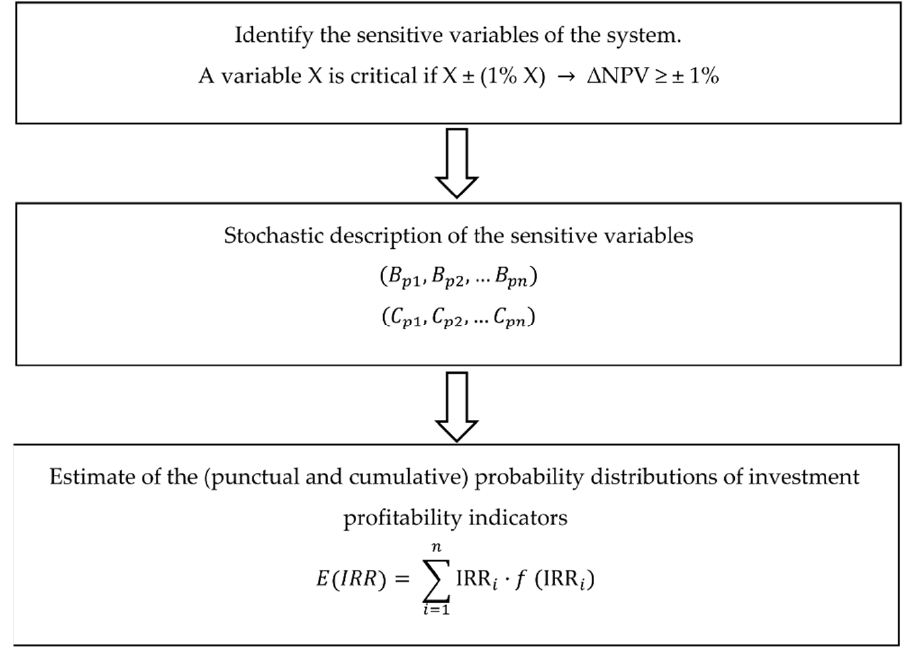
Figure 5. Risk analysis steps in the economic evaluation of the projects.